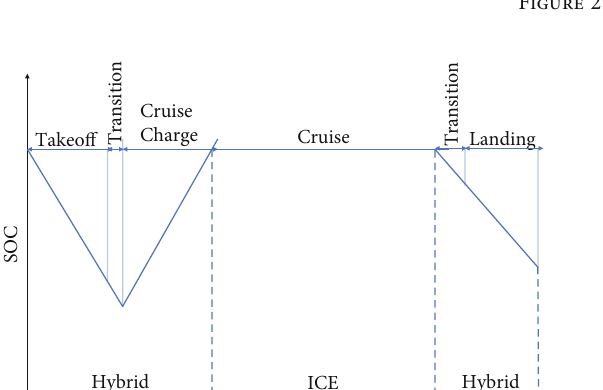
Figure 2: Map of ICE.